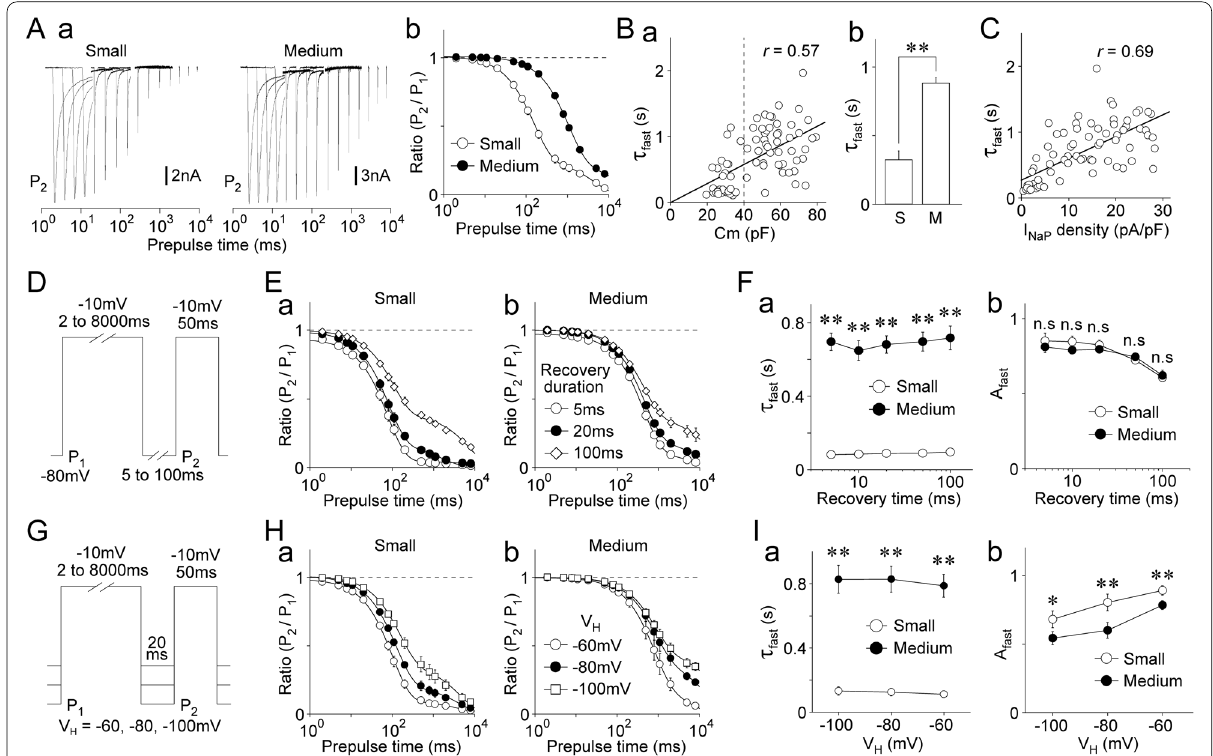
Fig. 4 Inactivation kinetics of TTX‑R Na + channels in dural afferent neurons. A. a , Typical second (P 2 ) traces of TTX‑R I Na elicited by a two‑pulse protocol in small‑ (left) and medium‑sized (right) DiI‑positive neurons. TTX‑R I Na were induced by the first conditioning pulse (P 1 : ‑10 mV; 2–8,000 ms duration), which was followed by the second test pulse (P 2 : ‑10 mV; 50 ms duration) with an interpulse interval of 20 ms at a potential of ‑80 mV (Supplementary Fig. S2A). b , Kinetics for the development of inactivation of TTX‑R Na + channels in small‑ (open circles) and medium‑sized (closed circles) DiI‑positive neurons. The P 2 /P 1 ratio of TTX‑R I Na was plotted against the duration of the conditioning prepulse. The points and error bars represent the mean and SEM from 28 small‑ and 47 medium‑sized DiI‑positive neurons. The continuous lines represent the best fits using a double exponential function. B. a , Scatter plot of the weighted time constant (τ fast ) against membrane capacitance (Cm) ( n 75). The linear trend line = represents the best fit using a least‑squares fit ( r 0.57). b , The mean values of τ fast in small‑ (S) and medium‑sized (M) DiI‑positive neurons. The = columns and error bars represent the mean and SEM from 28 small‑ and 47 medium‑sized DiI‑positive neurons, respectively. **; p < 0.01 (unpaired t‑test). C , Scatter plot of τ fast against the density of TTX‑R I NaP ( n 75). The linear trend line represents the best fit using a least‑squares fit ( r 0.69). = = D , Schematic illustration of the two‑pulse protocol. TTX‑R I Na were induced by the first conditioning pulses (P 1 : ‑10 mV; 2–8,000 ms duration), which were followed by the second test pulses (P 2 : ‑10 mV; 50 ms duration). The second TTX‑R I Na was recovered with interpulse intervals of 5, 10, 20, 50, and 100 ms at a potential of ‑80 mV. E. Kinetics for the development of inactivation of TTX‑R Na + channels with recovery durations of 5 ms (open circles), 20 ms (closed circles), and 100 ms (open diamonds) in small‑ ( a ) and medium‑sized ( b ) DiI‑positive neurons. The P 2 /P 1 ratio of TTX‑R I Na was plotted against the duration of the conditioning prepulse. The points and error bars represent the mean and SEM from eight small‑ and eight medium‑sized DiI‑positive neurons. The continuous lines represent the best fits using a double exponential function. F. The mean values of τ fast ( a ) and A fast ( b ) at different recovery durations of a two‑pulse protocol in small‑ (open circles) and medium‑sized (closed circles) DiI‑positive neurons. The points and error bars represent the mean and SEM from eight small‑ and eight medium‑sized DiI‑positive neurons. Notably, τ fast values were not related to the recovery duration in both types of DiI‑positive neurons. **; p < 0.01, n.s; not significant (unpaired t‑test). G. Schematic illustration of the two‑pulse protocol. TTX‑R I Na were induced by the first conditioning pulse (P 1 : 2–8,000 ms duration), which was followed by the second test pulse (P 2 : 50 ms duration) with an interpulse interval of 20 ms at holding potentials of ‑100, ‑80, and ‑60 mV, respectively. H. Kinetics for the development of inactivation of TTX‑R Na. + channels at V H s of ‑60 mV (open circles), ‑80 mV (closed circles), and ‑100 mV (open squares) in small‑ ( a ) and medium‑sized ( b ) DiI‑positive neurons. The P 2 /P 1 ratio of TTX‑R I Na was plotted against the duration of the conditioning prepulse. The points and error bars represent the mean and SEM from seven experiments for small‑ and medium‑sized DiI‑positive neurons, respectively. The continuous lines represent the best fits using a double exponential function. I. The mean values of τ fast ( a ) and A fast ( b ) at different V H s of a two‑pulse protocol in small‑ (open circles) and medium‑sized (closed circles) DiI‑positive neurons. The points and error bars represent the mean and SEM from seven small‑ and seven medium‑sized DiI‑positive neurons. Notably, τ fast values were not related to V H in both types of DiI‑positive neurons. *; p < 0.05, **; p < 0.01, n.s; not significant (unpaired